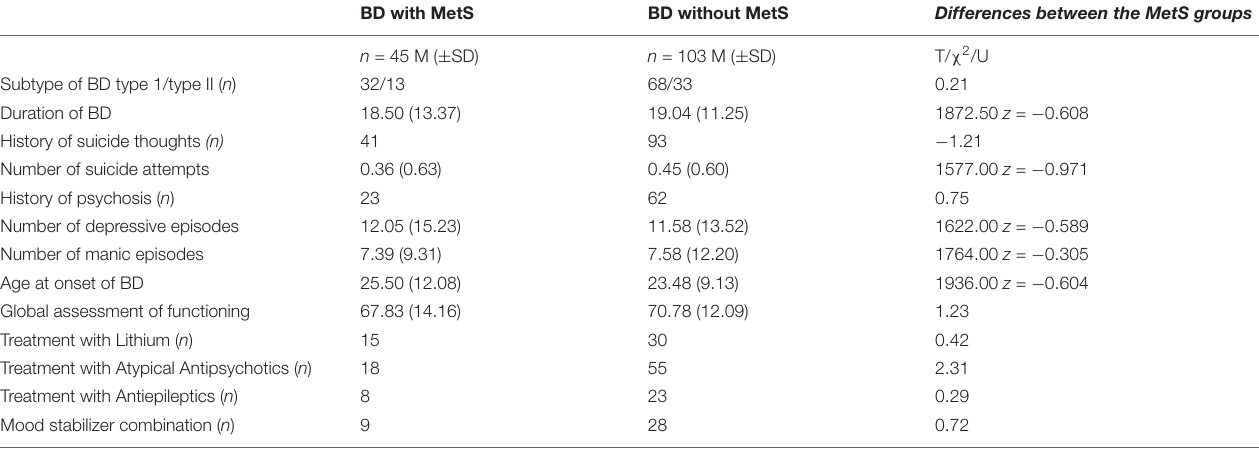
TABLE 2 | Clinical characteristics in participants with BD with and without MetS.